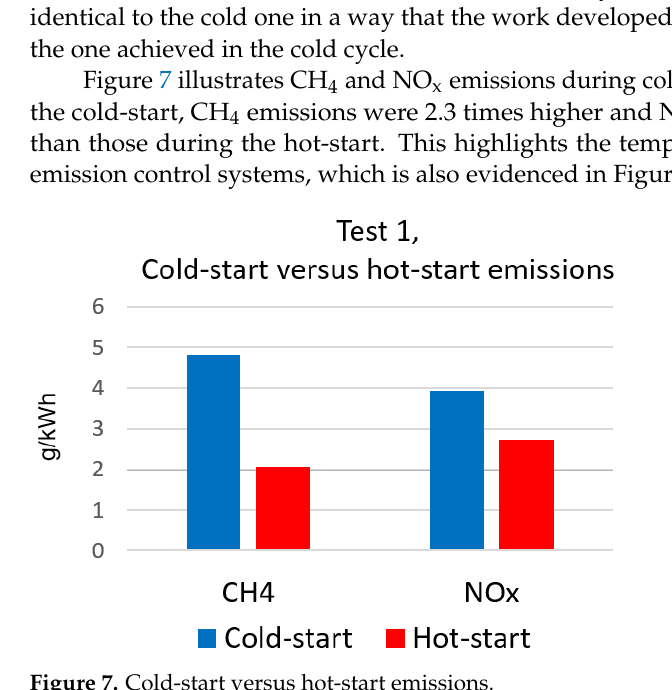
Figure 8. CH 4 emissions during combined cold- and hot-start test. Over the combined cold- and hot-start cycles, CH 4 emissions increased by 30%, NO x by 13%, and CO by 33% compared to hot-start-only measurements. The cold-start emissions challenge is more pronounced at low ambient temperatures because it then takes longer for the TWC to reach effective operating temperature, leading to a prolonged period of high emission rates [18,20,21]. 3.3. Well-to-Wheels Analysis In the transport sector, well-to-wheels (WTW) analysis is a commonly used method for assessing the carbon intensity of a fuel. Carbon intensity refers to the amount of green- house gases — including CO 2 , nitrous oxide, and methane — released during the produc- tion and consumption of a transportation fuel, measured in grams of carbon dioxide equivalent per megajoule of energy (g CO 2 -eq./MJ). 3.3.1. Fuel Consumption The total fuel consumption in the hot-start test at − 5 °C was 21.9 MJ/km (6.1 kWh/km), corresponding to 0.306 kg/kWh and 47.1 kg/100 km. In June, at +18 °C, the vehicle showed better fuel economy with fuel consumption of 19.8 MJ/km (5.5 kWh/km), corresponding to 0.283 kg/kWh and 42.7 kg/100 km (Figure 9).